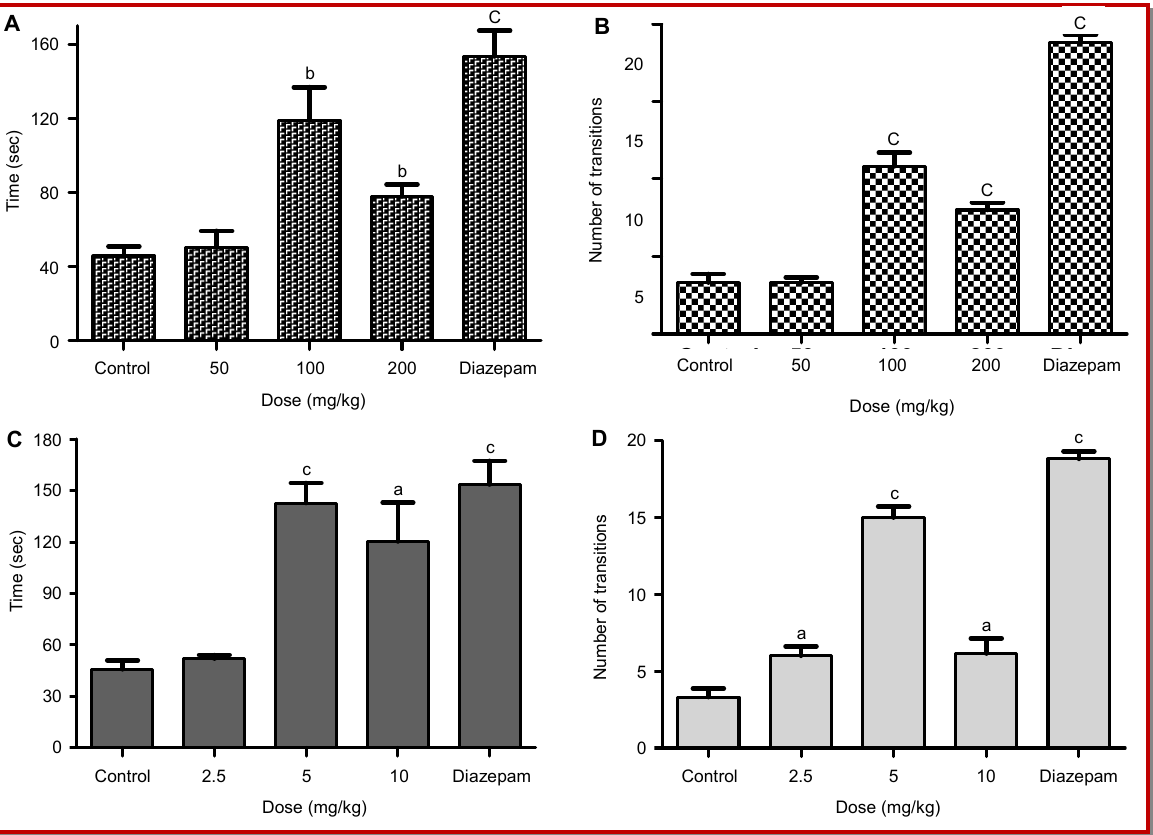
Figure 3: Effect of crude extract and n-hexane fraction of C. annuum at test doses in Light and dark model. Time spent on illumi- nated side (A), No of Transitions (B) for crude extract and Time spent on illuminated side (C), No of Transitions (D) for n-hexane fraction. Control (Saline and tween 80 2.5%), 50,100,200 mg/kg (crude extract of C. annuum ), 2.5, 5,10 mg/kg (n-hexane fraction of C. annuum ) and Diazepam 1 mg. All values are expressed as mean ± SEM, n=6., *: P<0.05, **: P<0.01,***: